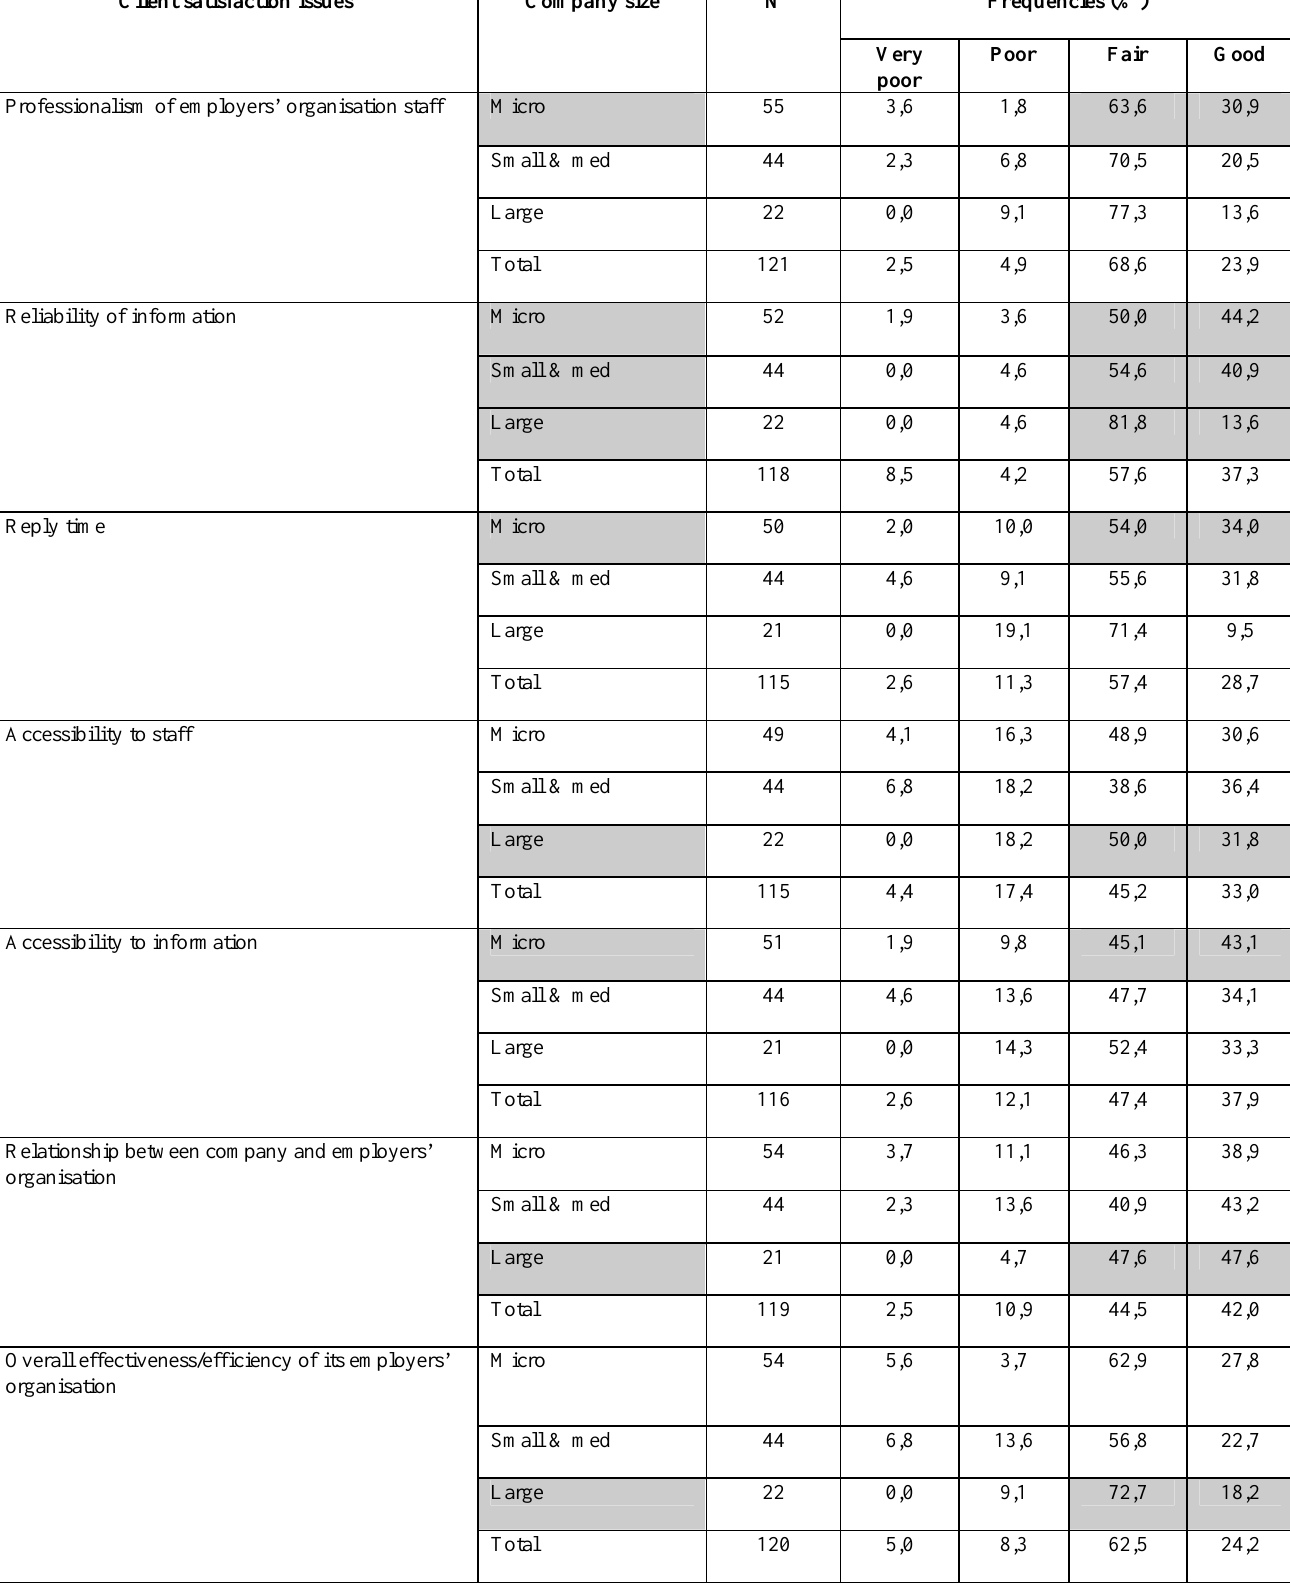
Table 8: Comparison between company size and client satisfaction Client satisfaction